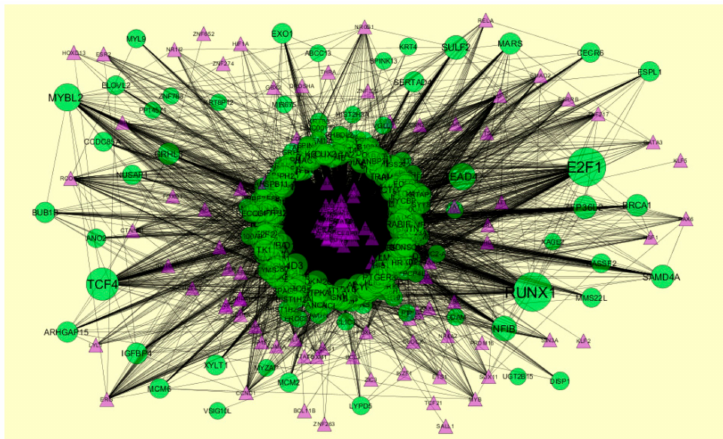
Figure 15. The network of up-regulated di ff erential expressed genes (DEGs) and their related transcription factors (TFs). (Lavender triangles—TFs, and green circles—target up-regulated genes).